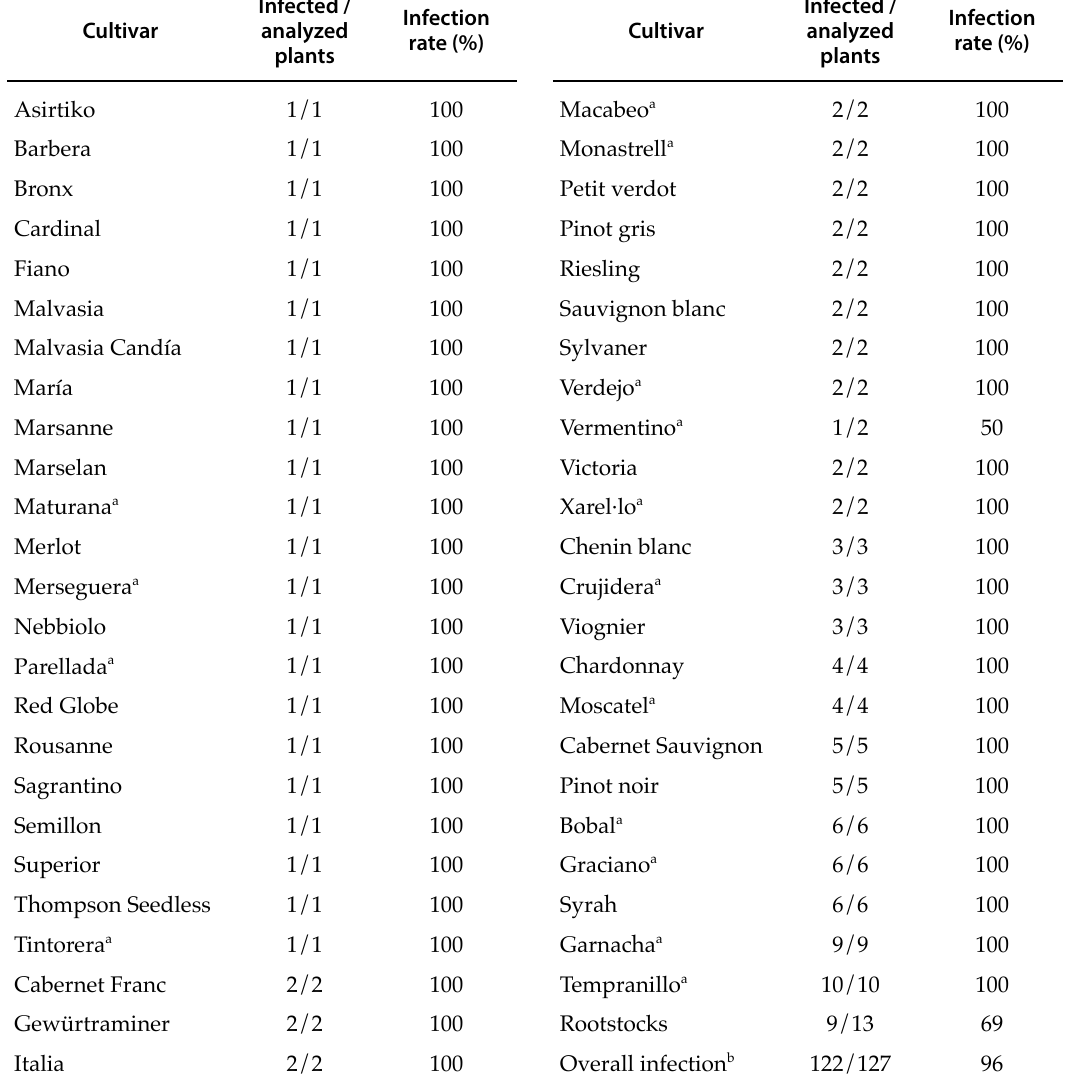
Table 1. Number and rates of infected plants for each grapevine cultivar tested in Requena.